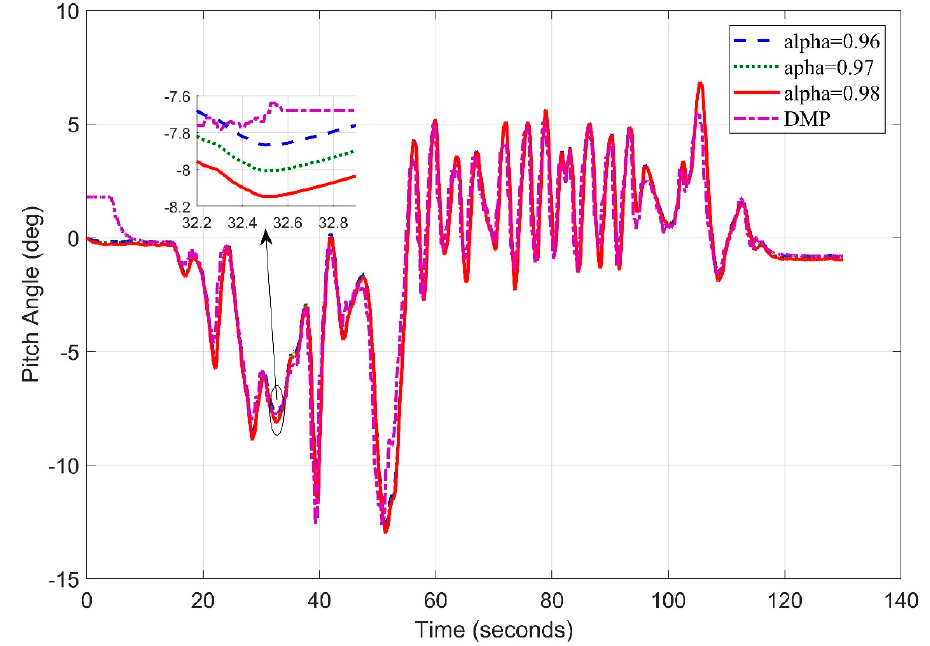
Figure 22. Time Pitch Angle Estimate at f = 10 Hz for Complementary Filter.